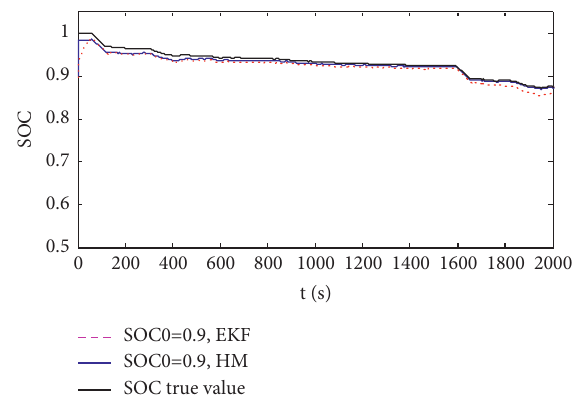
Figure 8: The convergence speed of EKF and HM under SOC 0 � 0.9.